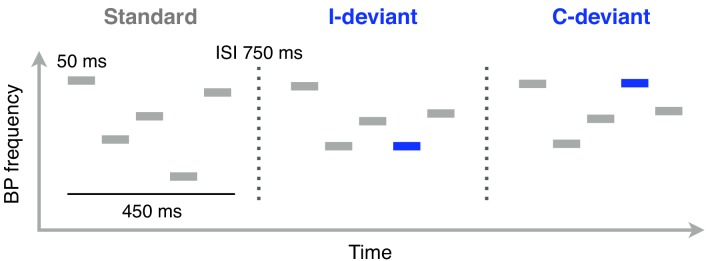
Schematic illustration of Bohlen-Pierce (BP) tone sequences used in the functional localizer task (auditory oddball).Functional MRI scanning was performed while participants listened to these sequences. Each sequence consisted of 5 sinusoidal 50 ms tones separated by 50 ms of silence. The intersequence interval (ISI; the silent gap between the offset of one sequence and the onset of the next one) was 750 ms. Standard sequences (80% of trials) were randomly transposed at different registers. Deviant sequences featured a change in pitch interval (interval deviants, I-deviants; 10%) or melodic contour (contour deviants, C-deviants; 10%) of the fourth tone, relative to its position in standard sequences.